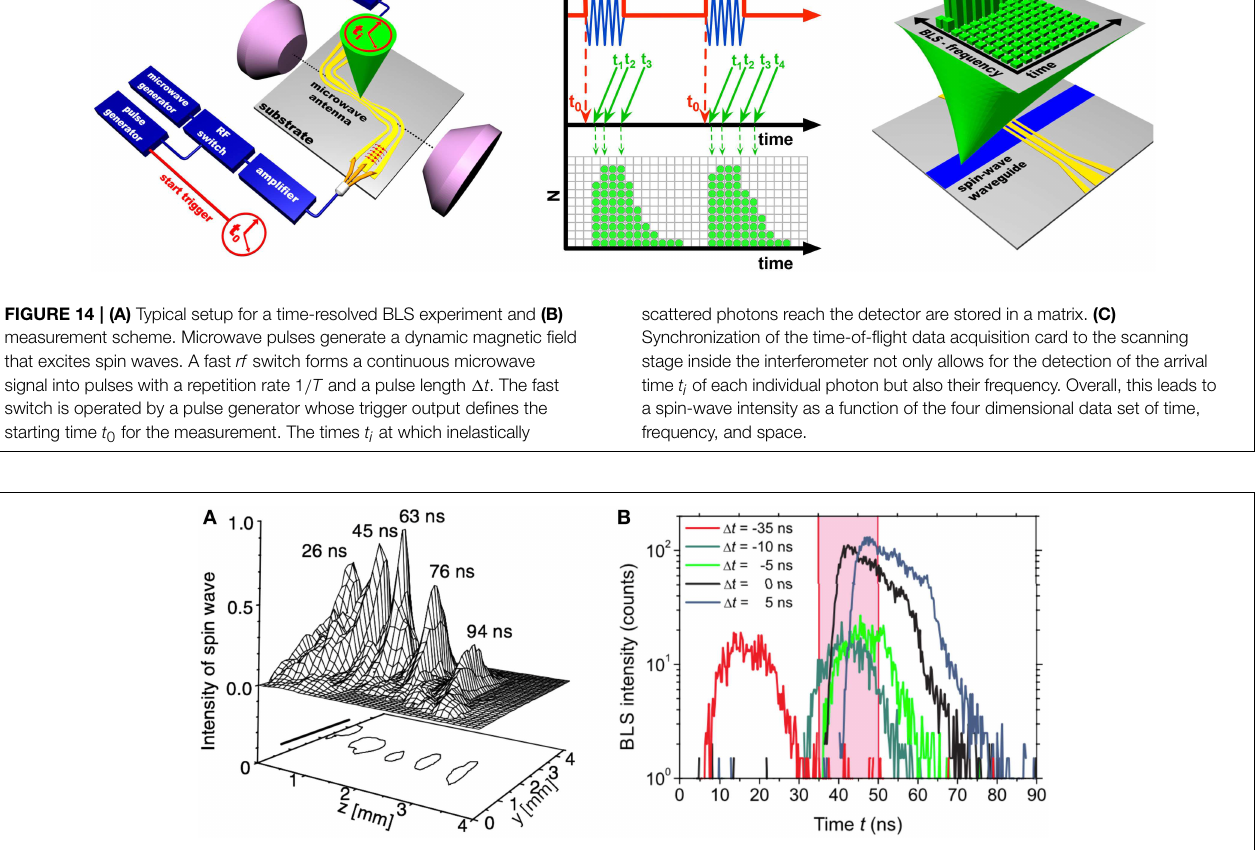
Frontiers in Physics |